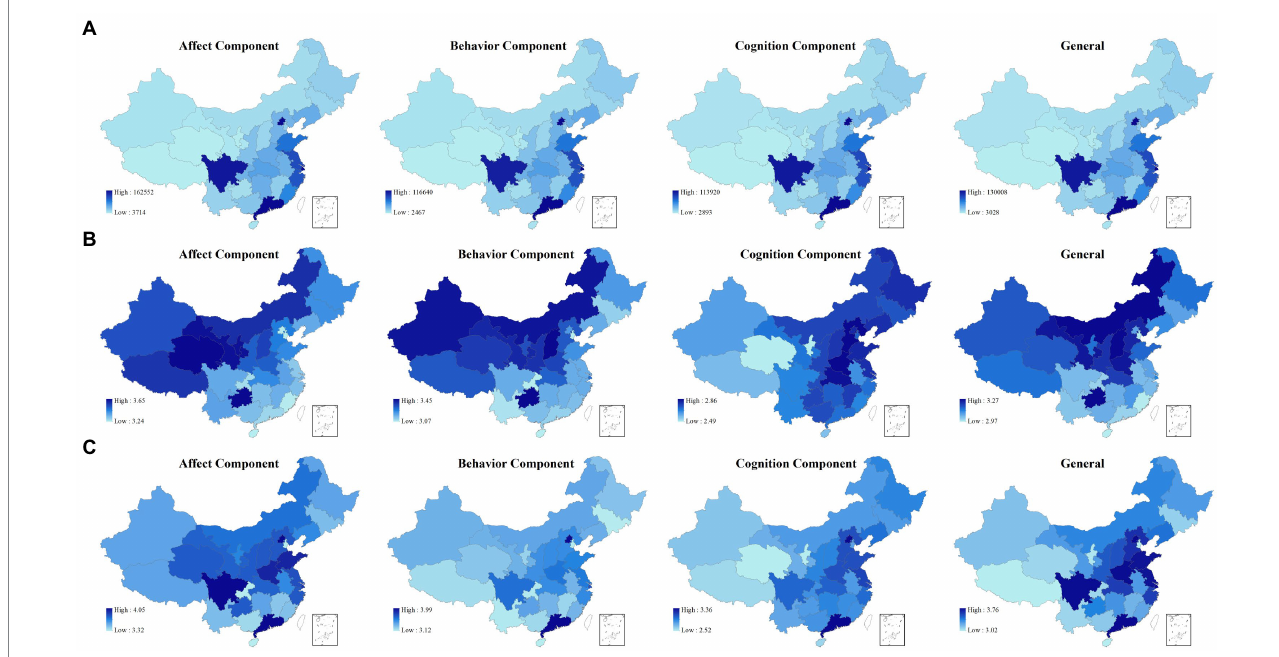
FIGURE 2 Choropleth maps: (A) Geographical distribution of Weibo text related to four aspects of Weibo users’ attitudes toward IWLG among 31 Chinese mainland provinces. (B) Geographical distribution of attitudinal score of four aspects of Weibo users’ attitudes toward IWLG among 31 Chinese mainland provinces. (C) Geographical distribution of adjusted attitudinal score of four aspects of Weibo users’ attitudes toward IWLG among 31 Chinese mainland provinces.